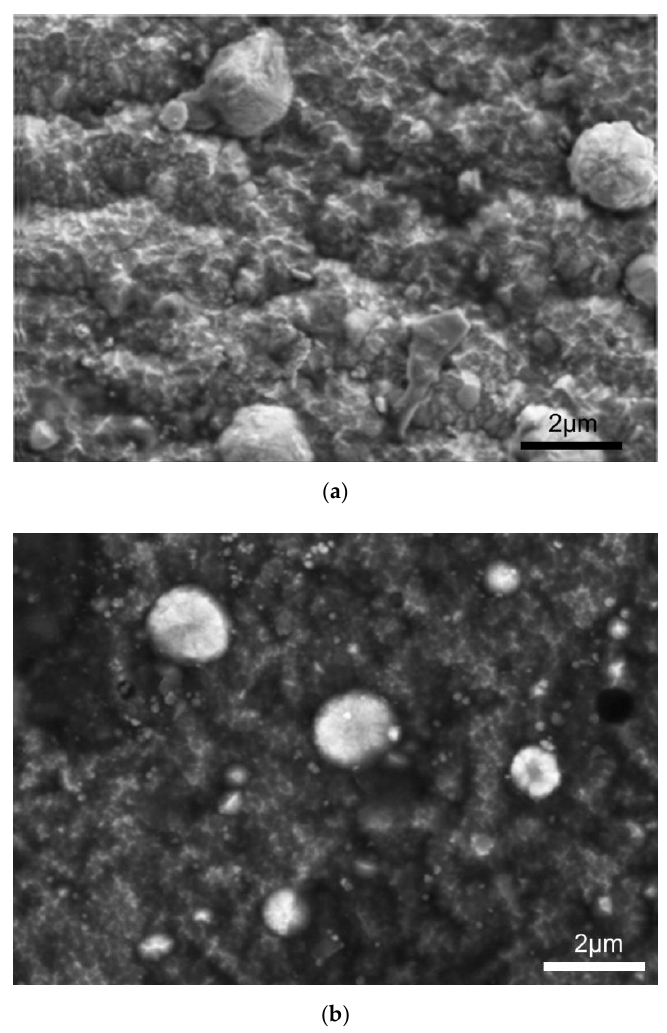
Figure 4. Surface morphology of the outside titanium nitride layer of the composite TiN2Ti1Al10 layer with modification produced by pressure hydrothermal treatment in overheated steam pro- cess: ( a ) before the process — as deposited (TiN2Ti1Al10) and ( b ) after the process